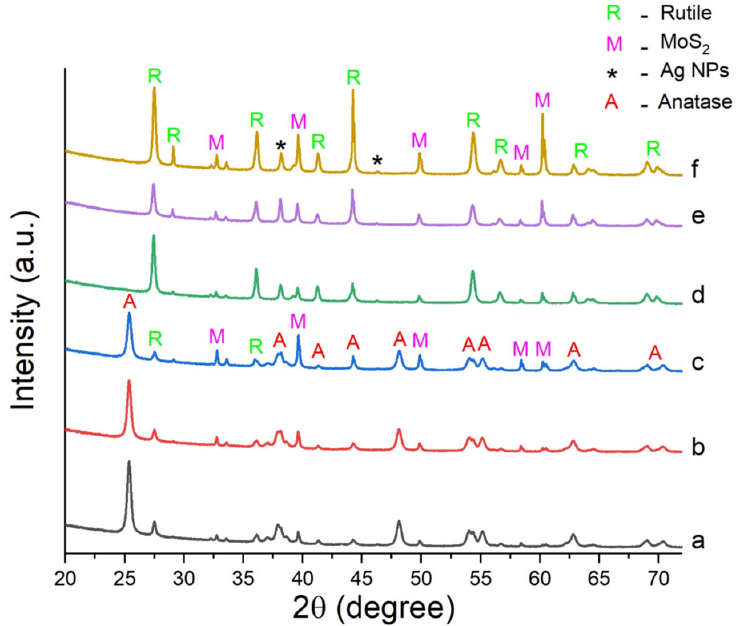
Figure 5. X-ray diffraction patterns (XRD) of 5%Ag@TiO 2 -P25-5%MoS 2 ( a ), 5%Ag@TiO 2 -P25- 10%MoS 2 ( b ), 5%Ag@TiO 2 -P25-20%MoS 2 ( c ), 5%Ag@TiO 2 NWs-5%MoS 2 ( d ), 5%Ag@TiO 2 NWs- 10%MoS 2 ( e ), 5%Ag@TiO 2 NWs-20%MoS 2 ( f ).